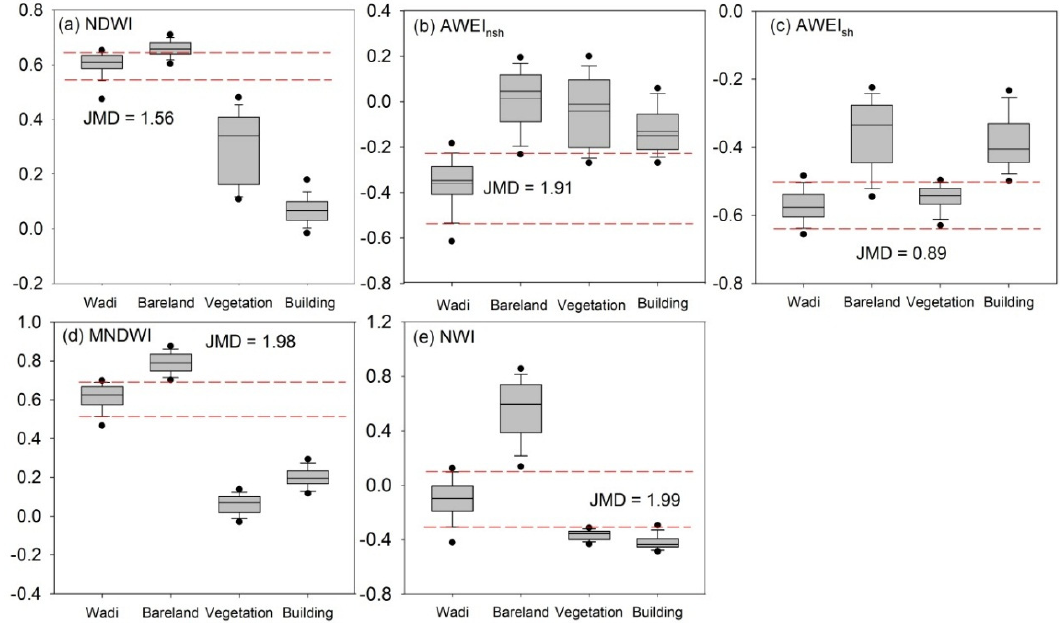
Figure 3. ( a – e ) WI value distributions for wadi, bare land, vegetation, and built-up land. In the box plots, the top and bottom of the vertical lines represent the maximum and minimum; the top and bottom of the boxes represent the first quartile and the third quartile; the lines in the boxes represent the median. The red line shows the reflectance separability of the third quartile of wadis reflectance with other landscapes, indicating possible reflectance confusion. The JMD is the average value for wadis and other three types.